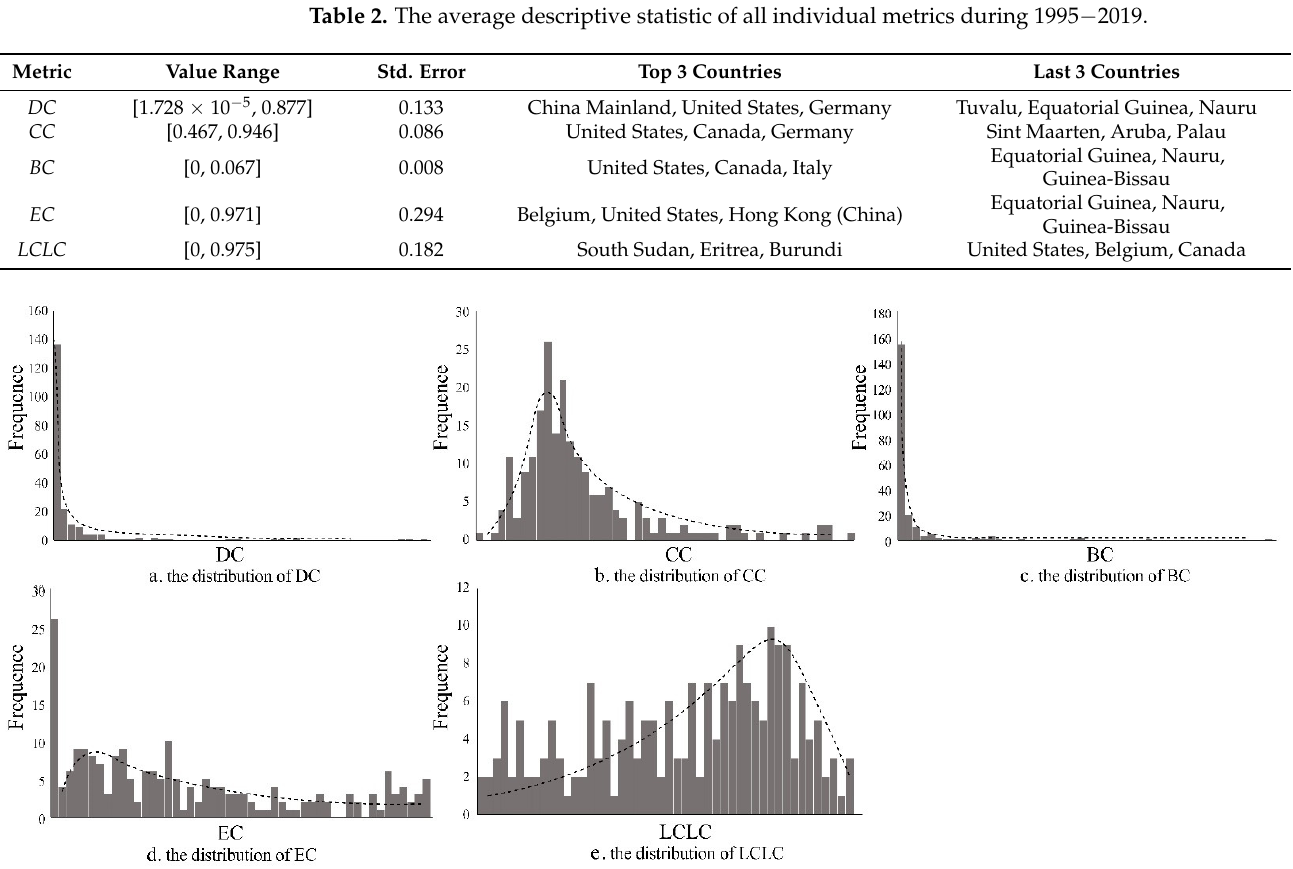
Figure 7. The distribution of all individual metrics.